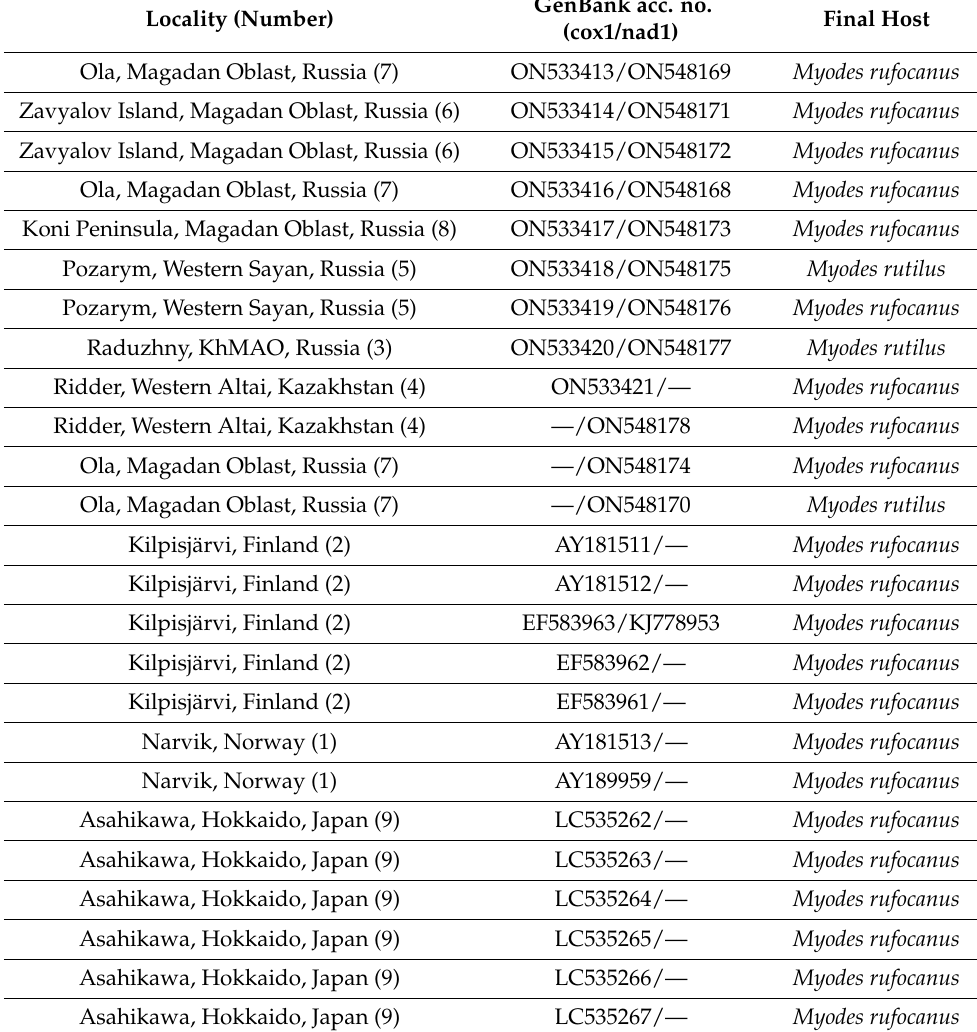
Table 1. List of examined specimens of Paranoplocephala kalelai and GenBank accession numbers according to geographical origin. Specimens with GenBank access numbers beginning with the letters ON were collected and sequenced by the authors. The other samples are given according to [4,5,11]. GenBank acc. Locality (Number)